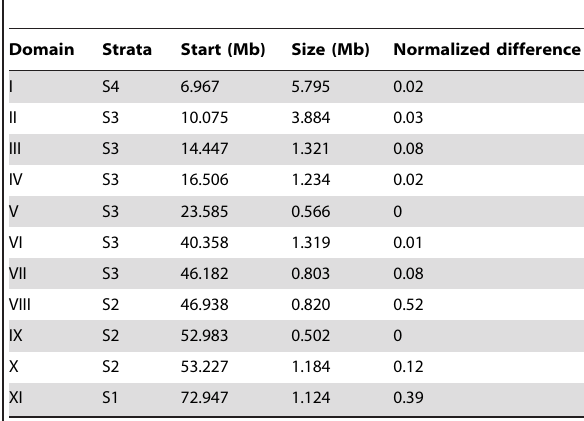
Table 2. Markov segmentation of domain pairs at the first partition